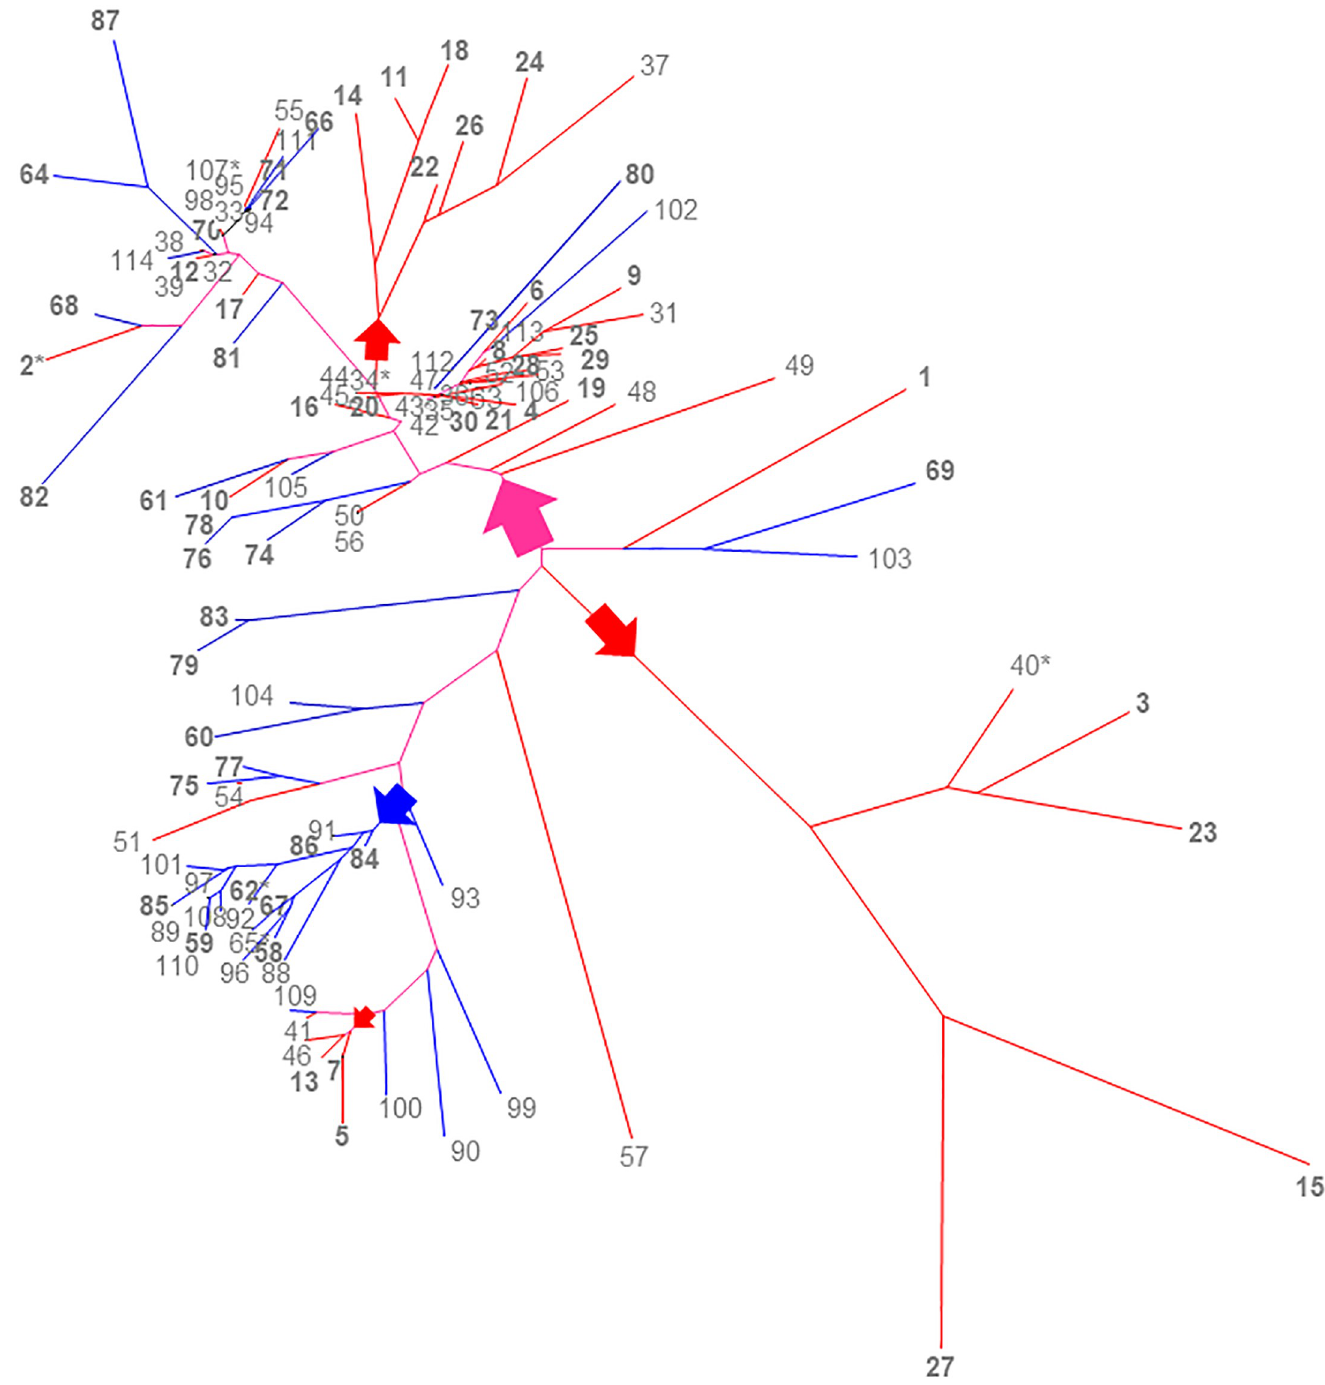
Fig 2. Unrooted neighbor-joining phylogenetic tree of AA (1–57 in red) and EA (58–114 in blue) regulatory haplotypes of SLC6A3 (violet, shared branches). 1– 29 and 58–87 (labeled in gray bold), carried by the patients and the rest by the controls. For top clade (at least five haplotypes), red arrows, AA clades; blue arrow, EA clade; violet arrow, clades with mixture of two ethnicities. � , carried by two subjects (the rest each carried by one subject). The proportion of sites where at least one unambiguous base was present in at least one haplotype for each descendent clade was either 99% or 100% for each internal node in the tree. The analyses utilized a total of 114